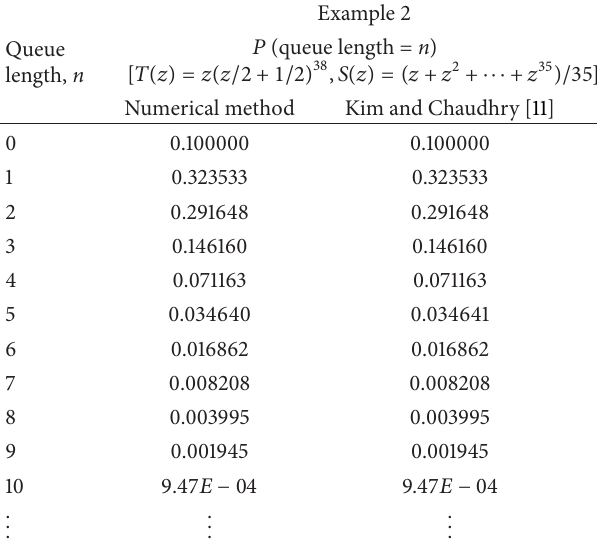
Table 5: Comparison of stationary queue length distribution com- puted using the proposed numerical method and that given in Kim and Chaudhry [11] ( Δ𝑡 =